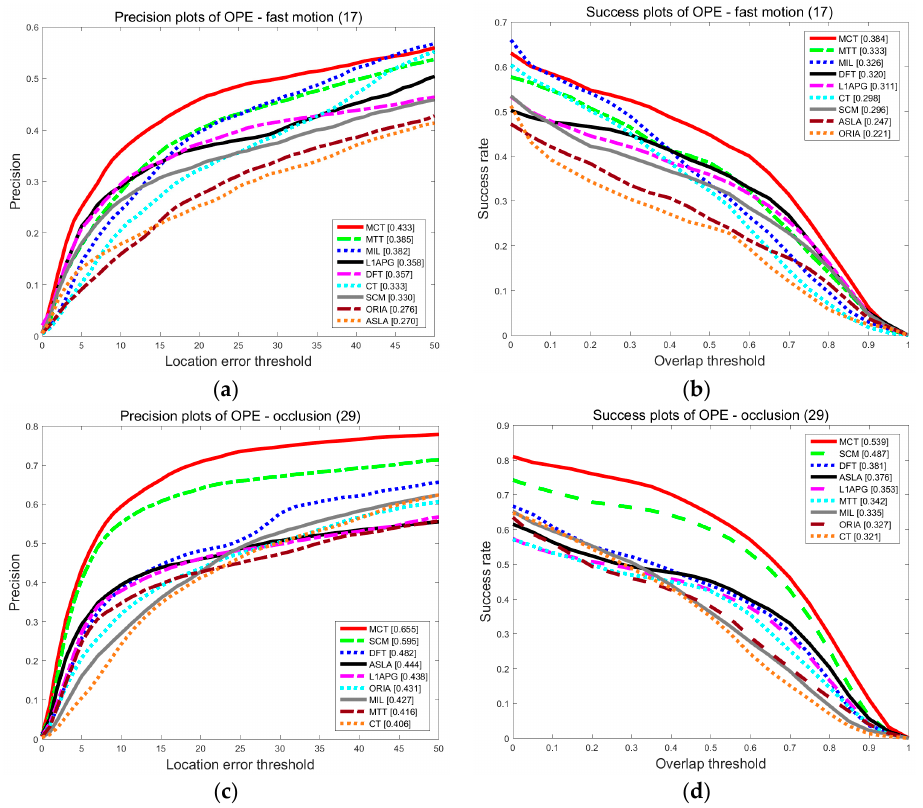
Figure 4. The precision plot ( a ) and the success rate plot ( b ) of the tracking results on OTB for FM, and the precision plot ( c ) and the success rate plot ( d ) of the tracking results on OTB for OCC. 2.